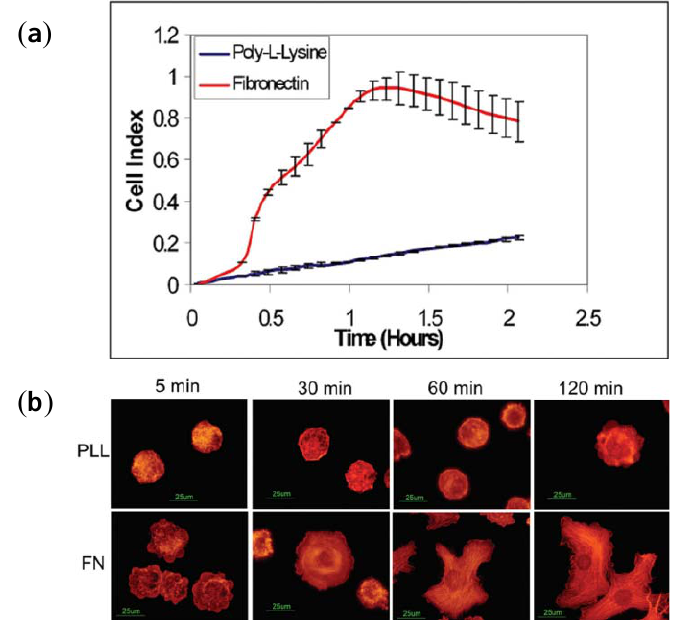
Figure 15. ( a ) Attachment and spreading of NIH3T3 cells on FN and PLL coated